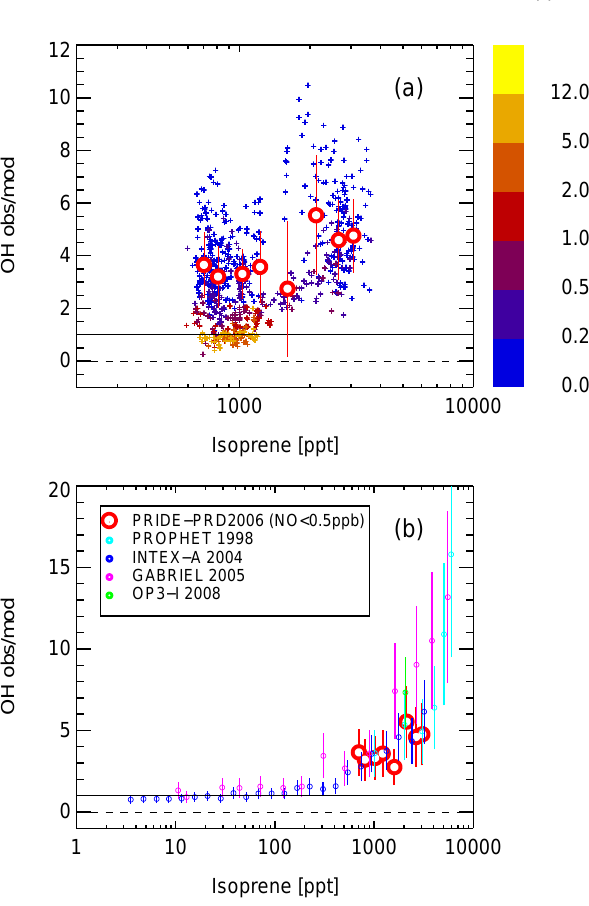
Fig. 10. The observed-to-modelled OH ratio as a function of isoprene at PRD backgarden (a) and its comparison to ratios reported from other field campaigns (b) . Panel (a) : the individual data points from Fig. 9b are color coded according to concurrently measured NO mixing ratios. The red open circles are average values of OH obs / OH mod over equally spaced ln([isoprene]/ppb) intervals for NO lower than 0.5ppb. The error bars denote the variability within each NO interval. Panel (b) : the averaged values from panel (a) (red open circles) are compared to OH obs / OH mod ratios reported from PROPHET (1998), INTEX (2004), GABRIEL (2006), and OP3-I (2008). Here, the error bars denote the stated measurement accuracies (2 σ ) of OH.